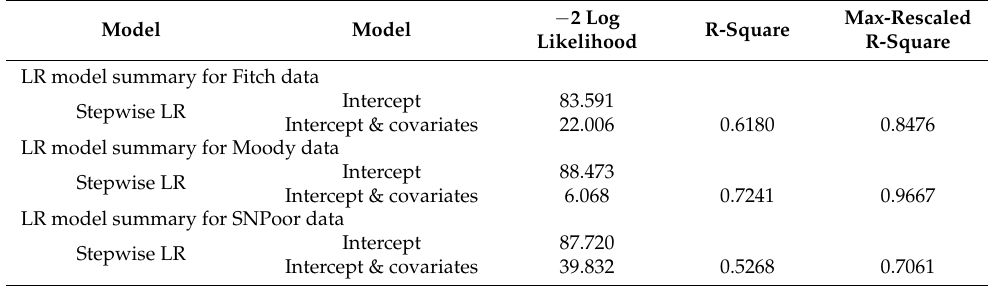
Table 4. Model summary for the logistic regression